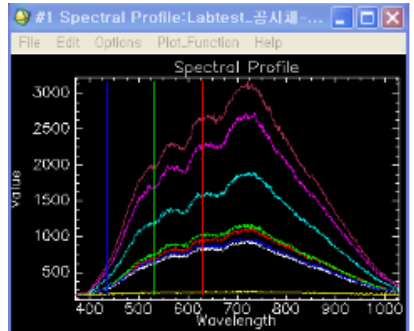
Figure 8. Spectral Profile